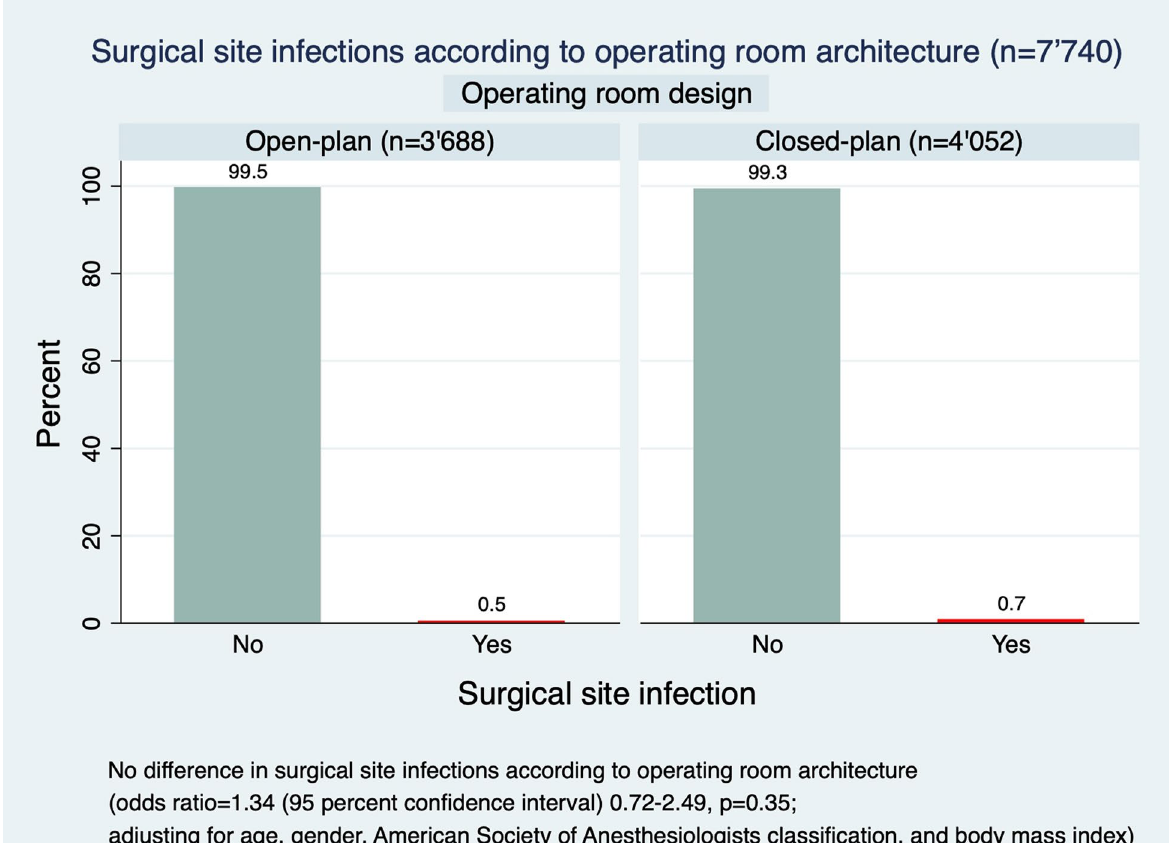
Figure 2. Surgical site infections according to operating room architecture.